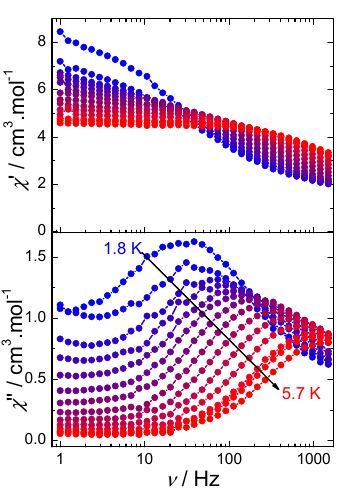
Figure 3. Frequency dependence of the in-phase ( χ ’) and out-of-phase ( χ″ ) components of the ac susceptibility under an optimal magnetic DC field of 2250 Oe for 1 . Solid lines are guides to the eye.